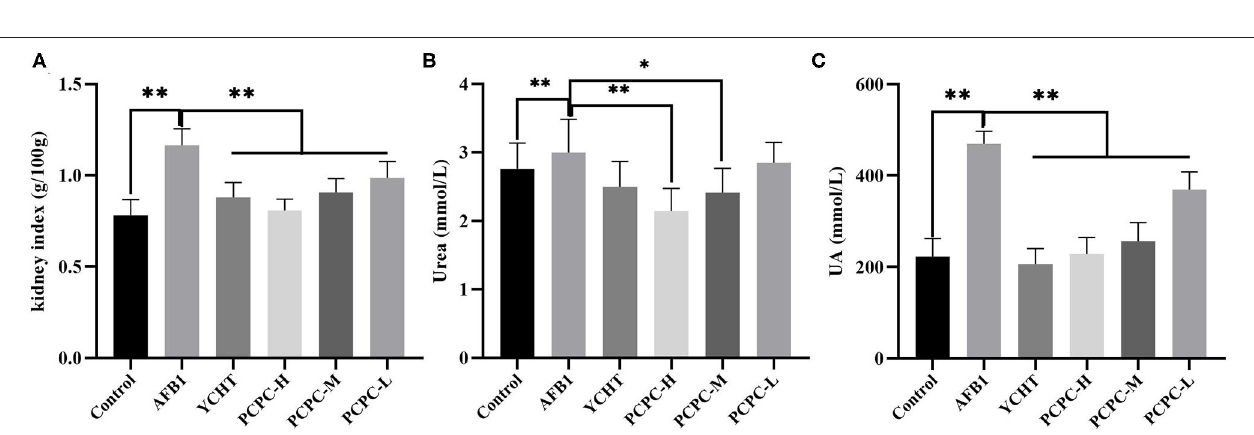
FIGURE 2 | Biochemical analysis of serum urea and UA levels and the kidney index analyzed on the 28th day of the experiment. (A) Kidney index; (B) Urea; (C) UA. Asterisk means values within columns are significantly different. * p < 0.05 and ** p < 0.01.